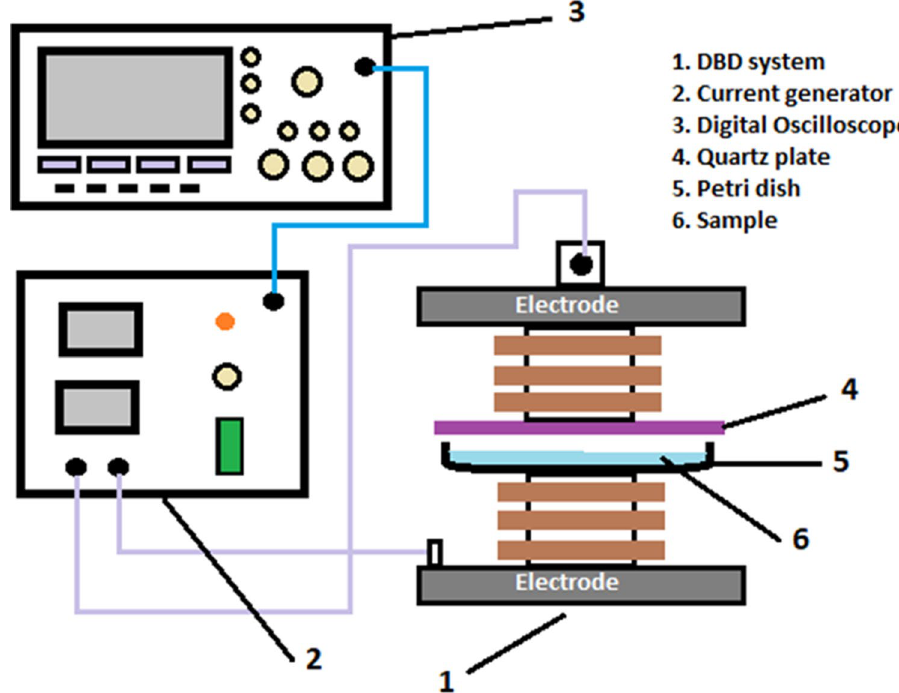
Fig. 1 Schematic diagram of dielectric barrier discharge (DBD) system used in this experiment. Operated at atmospheric pressure in ambient air and room temperature (20 ºC); 20 mL sample volume and 60 W input